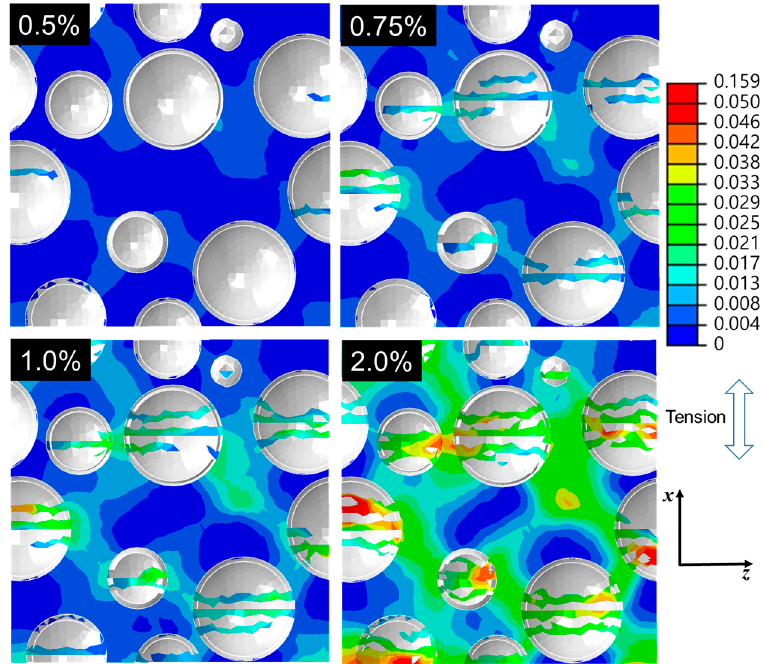
Figure 9. Plastic strain fields of a cross section of the (cid:1838) = 55 μ m RVE model subjected to x -axial tensile strain from 0.5% to 2.0%. The microspheres were colored in gray because no plastic deformation occurred.